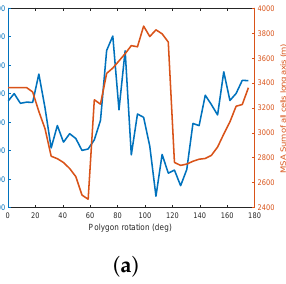
Figure 20. Cost function outputs across a range of polygon rotation angles, comparing cost functions FTIW to both MSA and NT. ( a ) Flight time in wind vs. MSA; ( b ) flight time in wind vs. number of